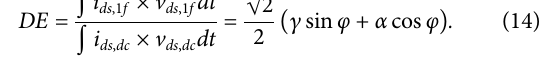
Frontiers in Physics |